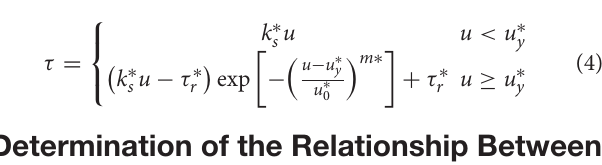
Frontiers in Earth Science |